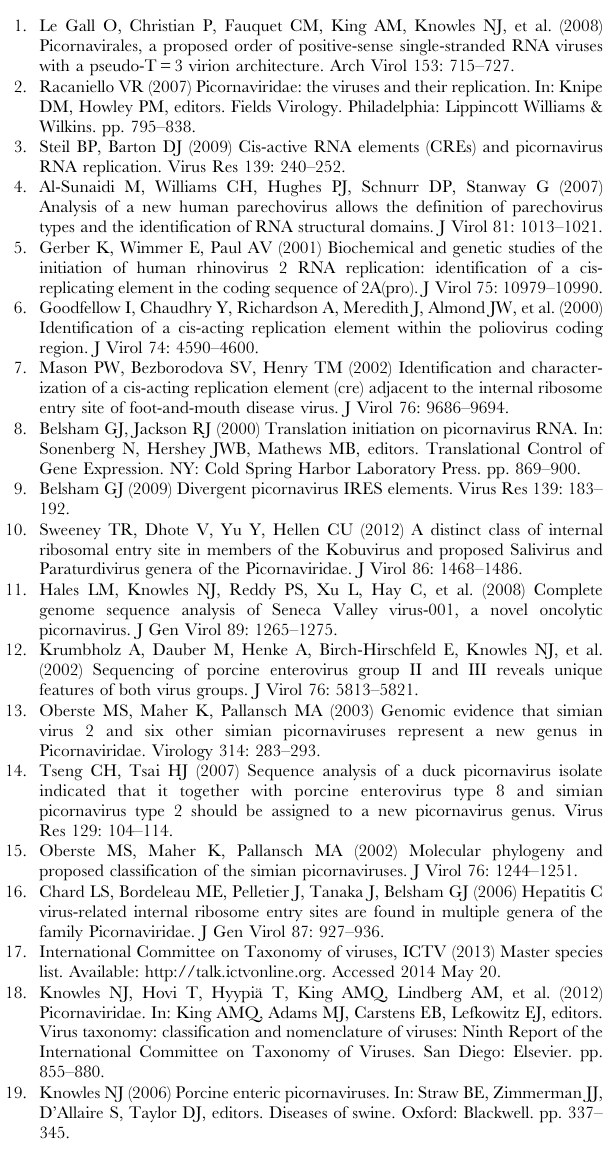
Figure S1 Phase contrast photomicrographs of control and infected LLC-PK1 cells, and RT-PCR assay for detecting porcine sapelovirus (PSV) VP1 coding region. (A) Mock-inoculated control cells. (B) Cells at 1 day after infection with Korean PSV strain KS05151. Note the shrinking and rounding up of the infected cells. Microscope settings Ocular: 10; for part of the PSV VP1 coding region generated the expected